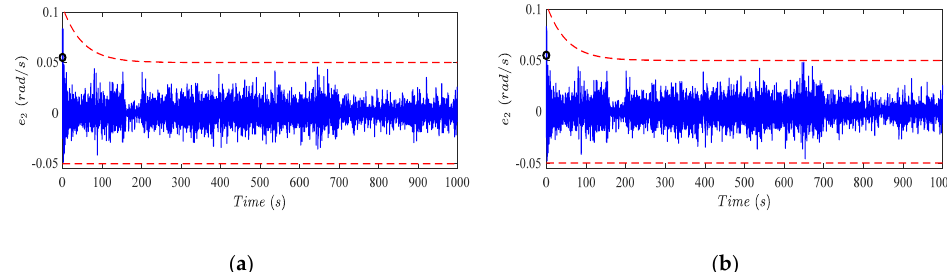
Figure 5. Tacking error e 2 (blue line) with constructed constraints (red dashed lines), under single ( a ) and simultaneous faults ( b ). The circle represents the initial value.